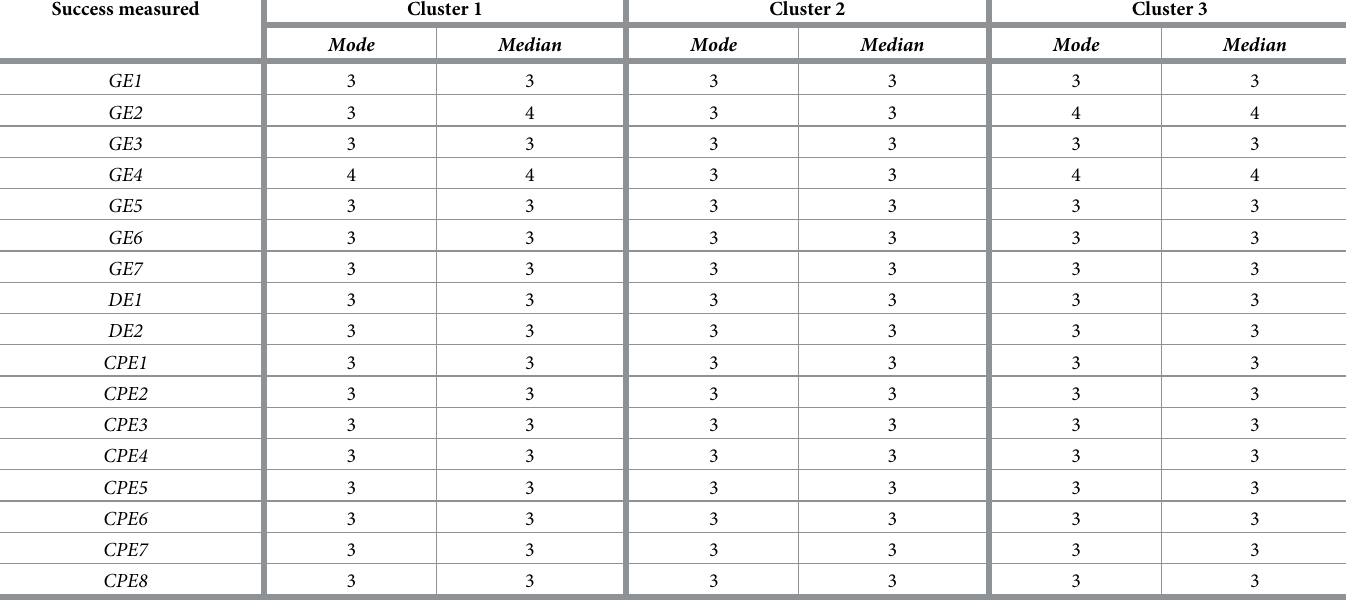
Table 4. Modal and medians values for individual variables of SME success. Success